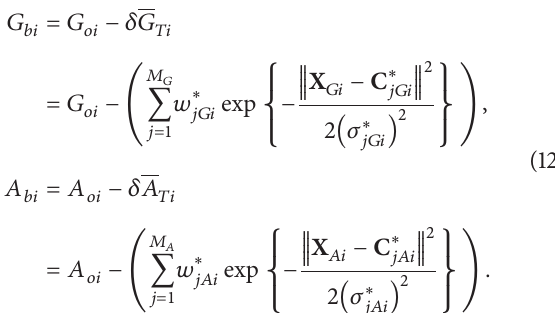
output of QMA bias 𝐴 𝑜𝑖 in the 𝑖 th axes. The final output of gyroscope and accelerometer in the 𝑖 th axes can be given by